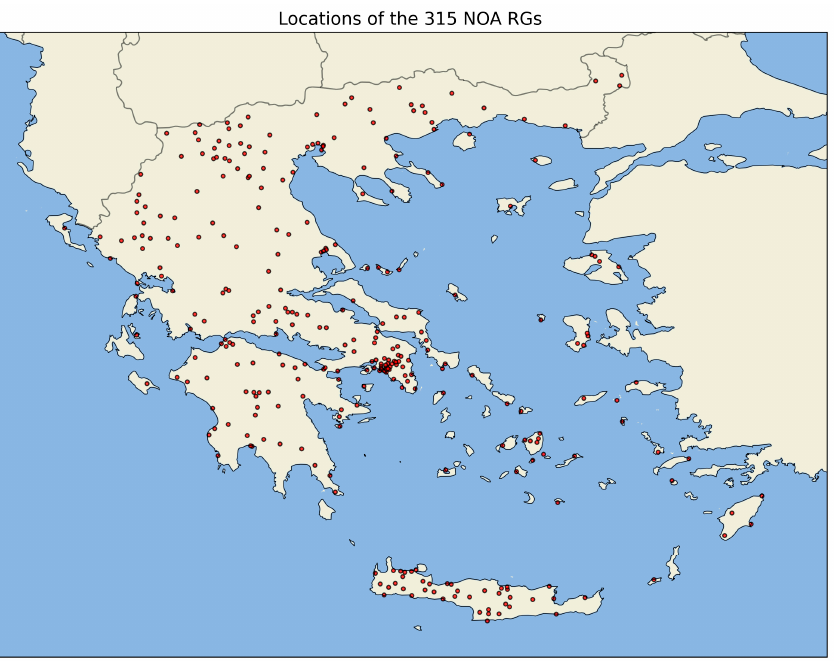
Figure 1. The locations of the 315